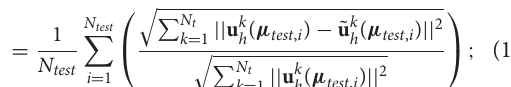
N train and N test are the number of training- and testing-parameter instances, respectively, N t is the number of time instances, N s = N train N t , and ω h ∈ [0, 1]. The POD-DL-ROM approximation of the FOM solution ˜ u h ( t ; µ ) ≈ u h ( t ; µ ) is then recovered by means of the rPOD basis matrix